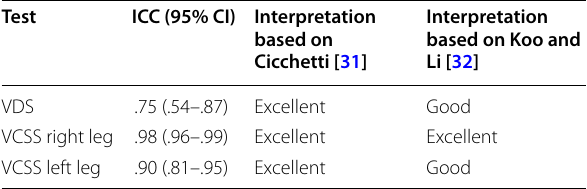
ICC intra-class correlation coefficient